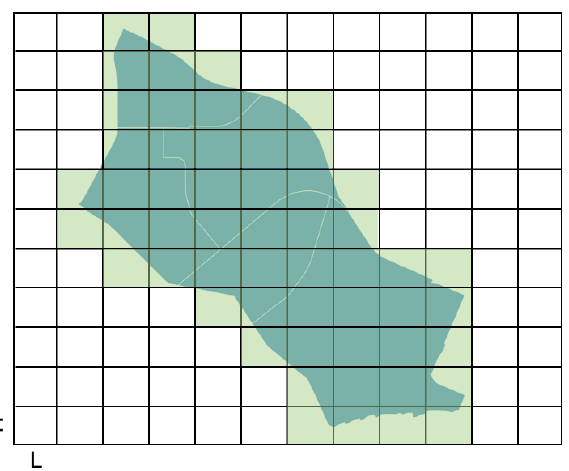
Figure 2. The data procurement step begins by defining the dimensions of a rectangular bounding box that envelopes the study area before dividing the bounding box into a grid pattern consisting of sub-bounding boxes. The study area’s shapefile is subsequently used to filter out all sub-bounding boxes that do not lie within its boundaries.